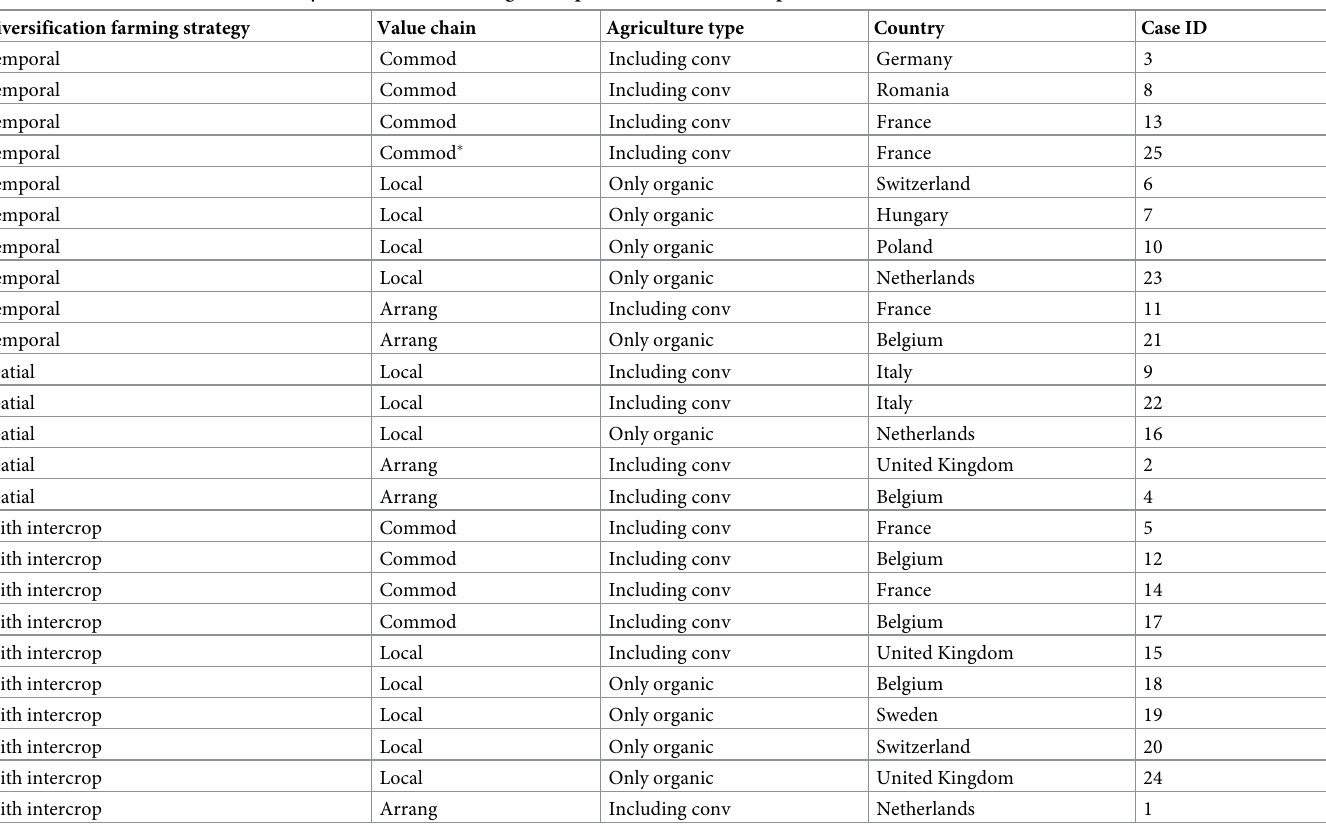
Table 1. Characteristics of the 25 food system innovation settings of crop diversification in Europe. Diversification farming